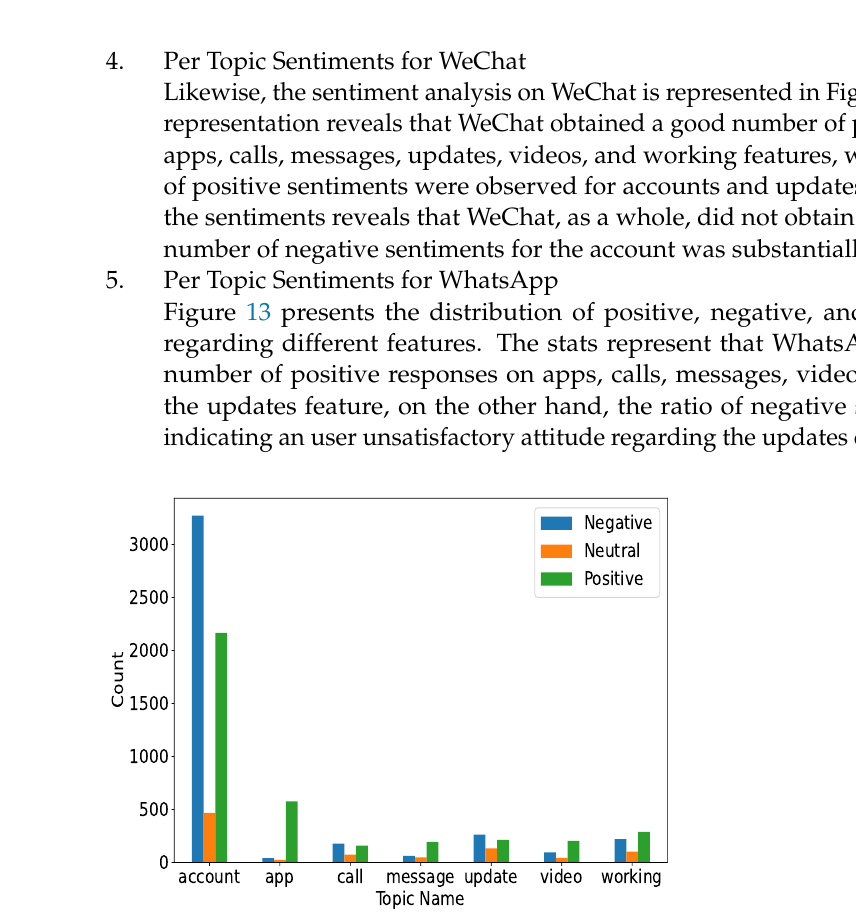
Figure 12. Sentiments for the WeChat app.